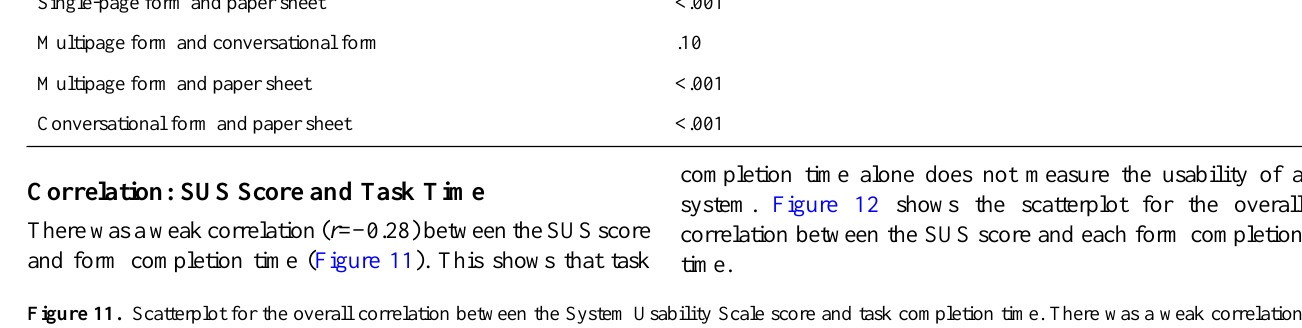
Figure 11. Scatterplot for the overall correlation between the System Usability Scale score and task completion time. There was a weak correlation ( r =−0.28) between the System Usability Scale score and form completion times. This shows that the task completion time alone does not measure the usability of a system. SUS: System Usability